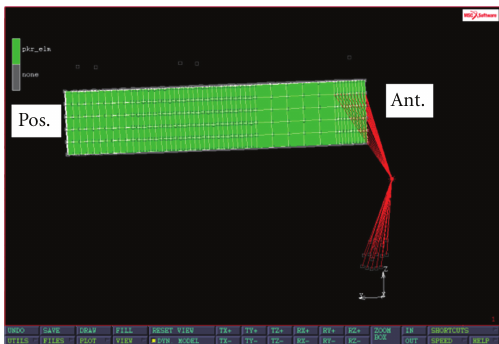
Figure 1: Sagittal view of a PKR model with no external fixations.